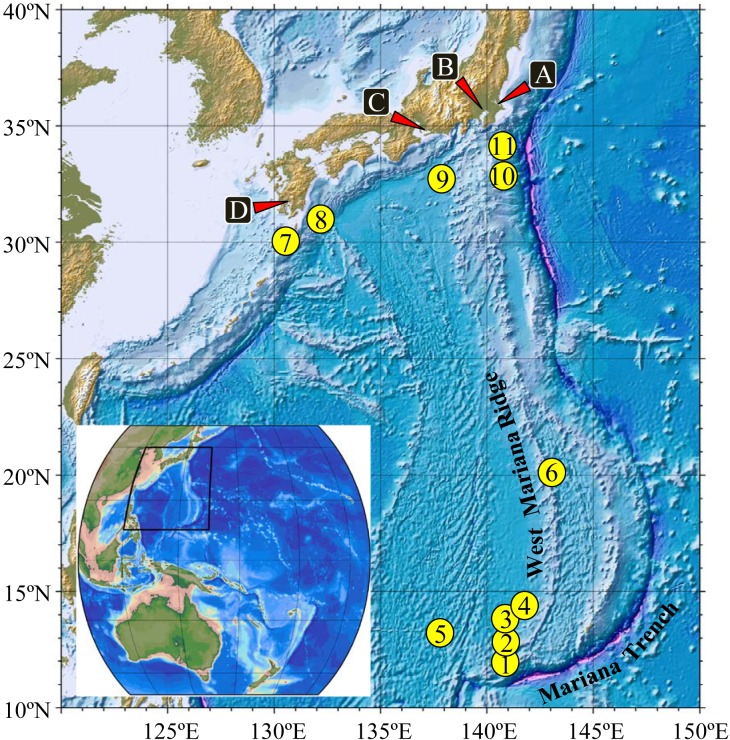
Four locations (A-D) for collecting the Japanese eels (Anguilla japonica) that were used for tracking, and eleven locations (1–11) where the eels were released and tracked.A: Tone River (Chiba Prefecture), B: Naka River (Tokyo), C: Mikawa Bay (Aichi Prefecture), D: Amikake River (Kagoshima Prefecture). 1–6: tropical to subtropical area (TS). 7–11: temperate area around Kuroshio Current (KC). See Tables 1 and 2 for details.